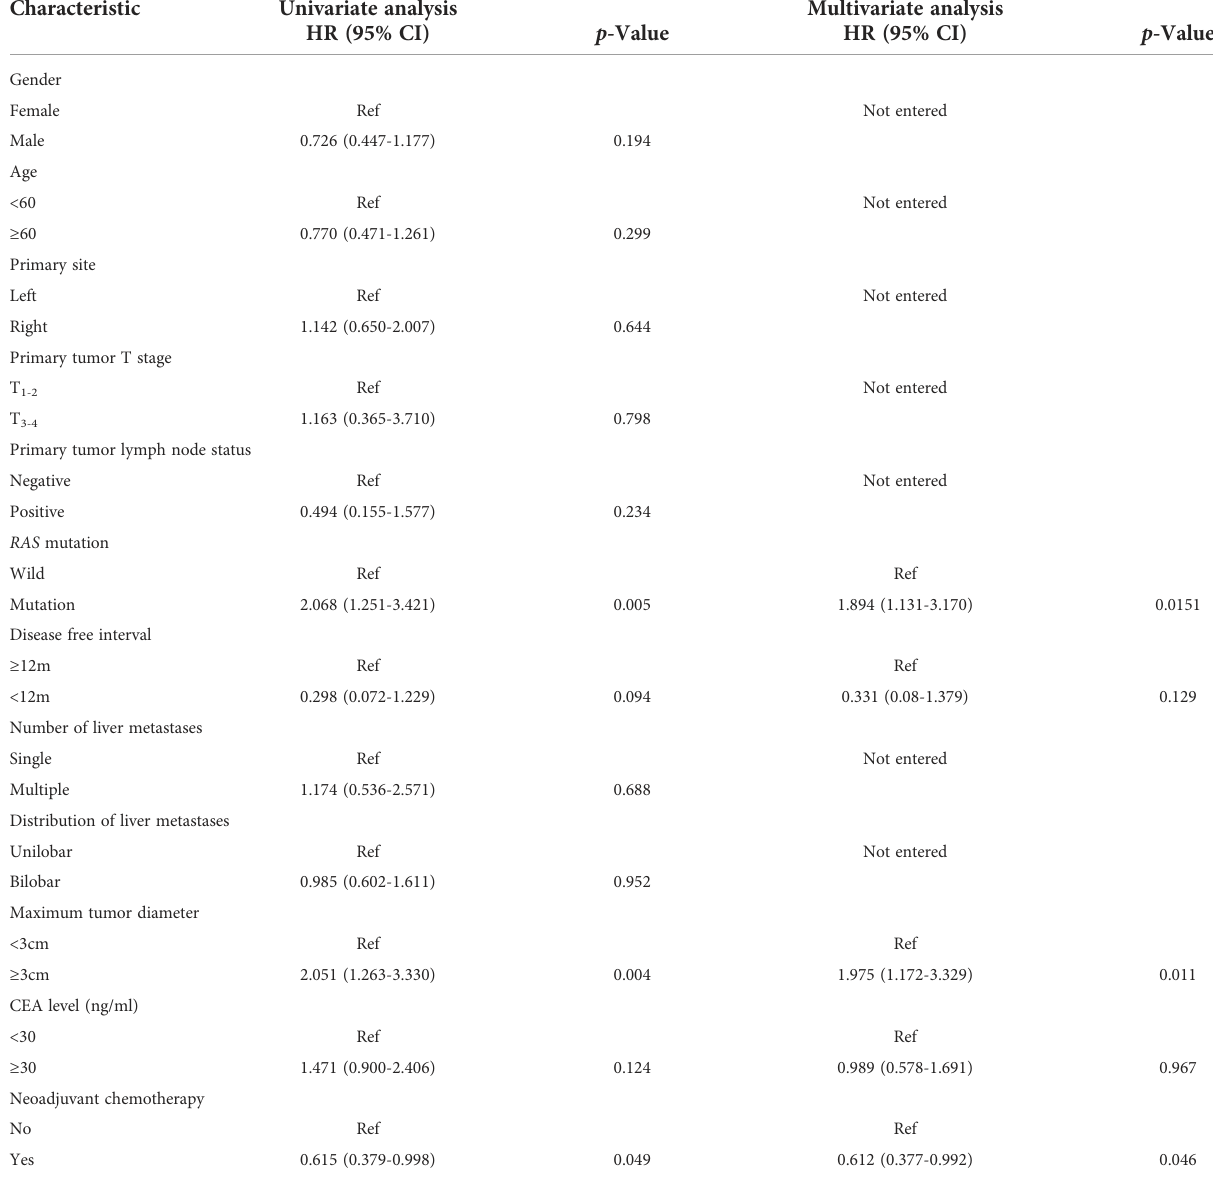
TABLE 3 Results of univariate and multivariate Cox regression analysis for overall survival in patients with upfront surgery or neoadjuvant chemotherapy after Propensity Score Matching analysis.